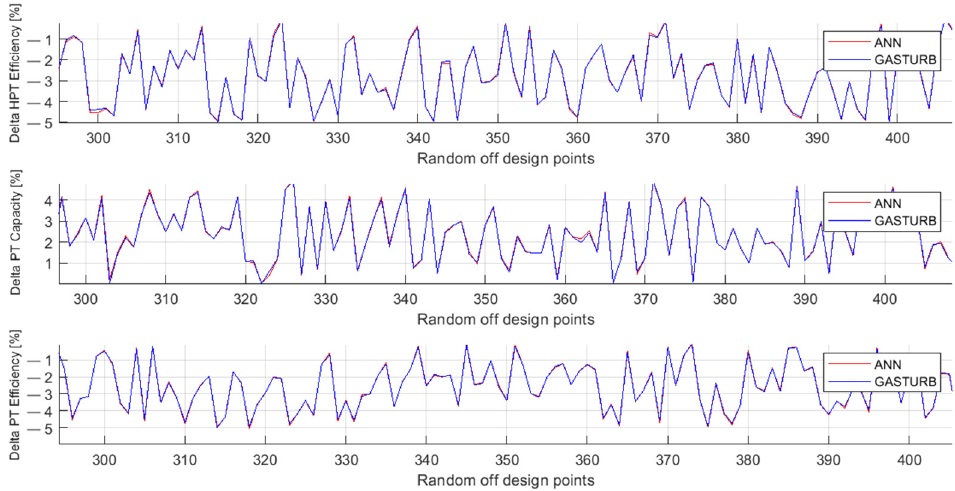
Figure 6. Fault parameters Δ HPTE, Δ PTC, and Δ PTE, true and simulated by MLP (Testing set).